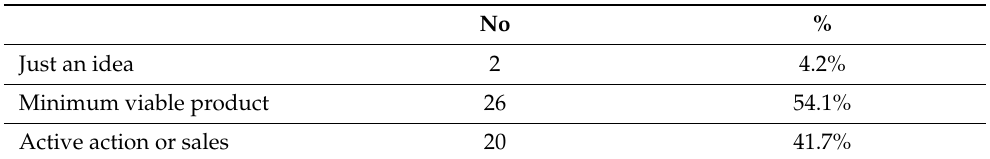
Table 3. The stage of development of respondents—incubated start-ups, percentage of respondents ( n = 48) (source: authors’